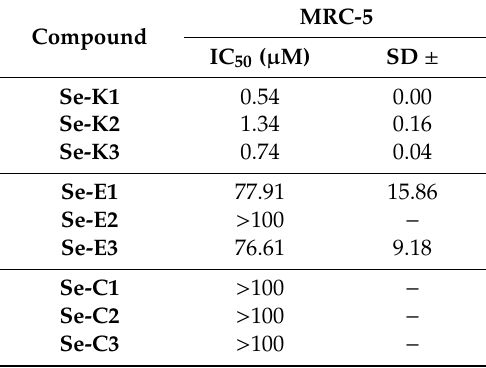
Table 4. Cytotoxic activity of selenocompounds on MRC-5 human embryonal fibroblast cells, expressed in Inhibitory Concentration 50 (IC 50 ) and with the calculated standard deviation